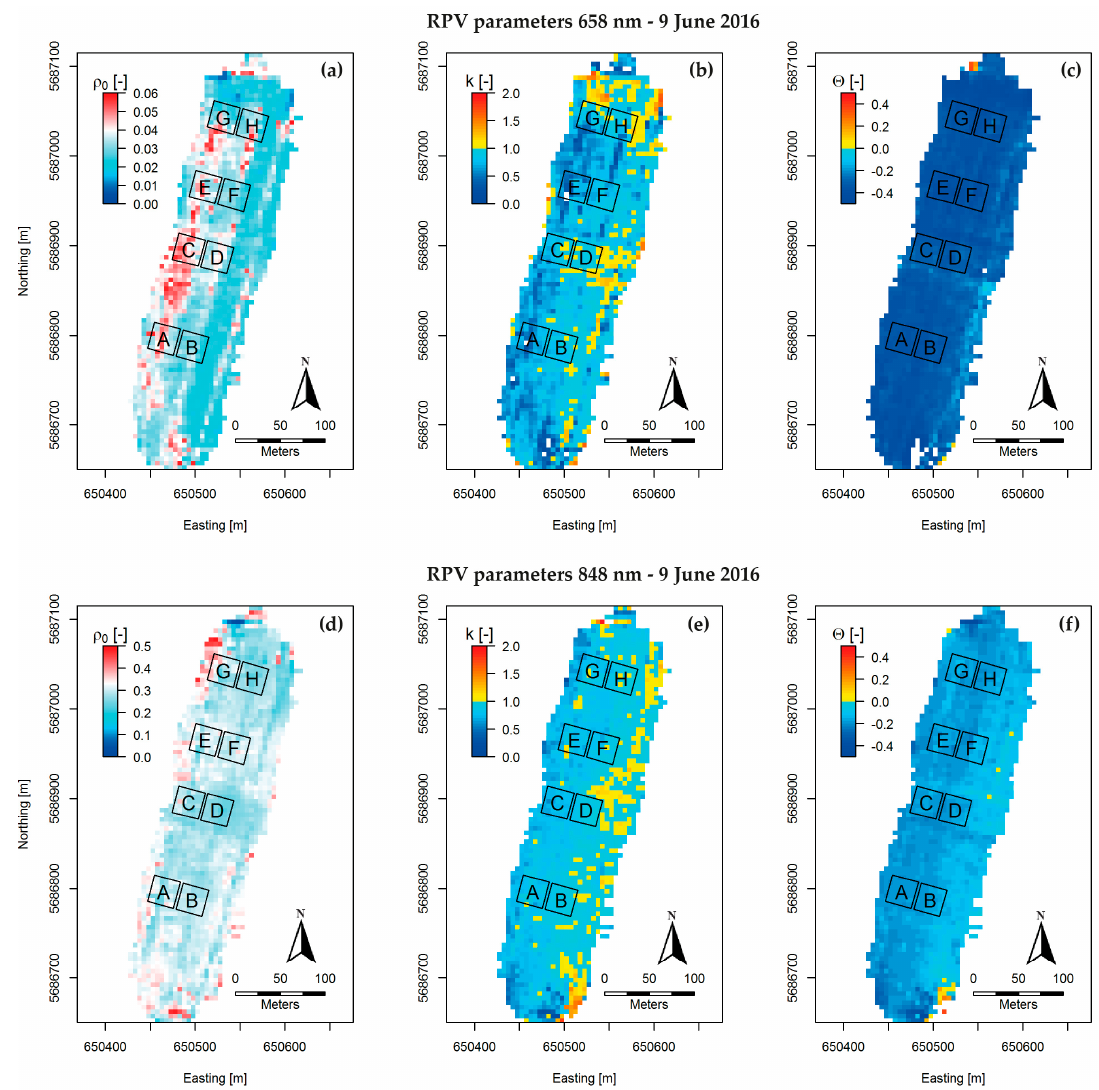
Figure 6. ρ 0 , k , and Θ parameters obtained by fitting the Rahman–Pinty–Verstraete (RPV) model through the measurements of Flight 1 (9 June 2016) at 658 nm ( a – c ) and at 848 nm ( d – f ). All figures are in WGS84 UTM 31N projection.